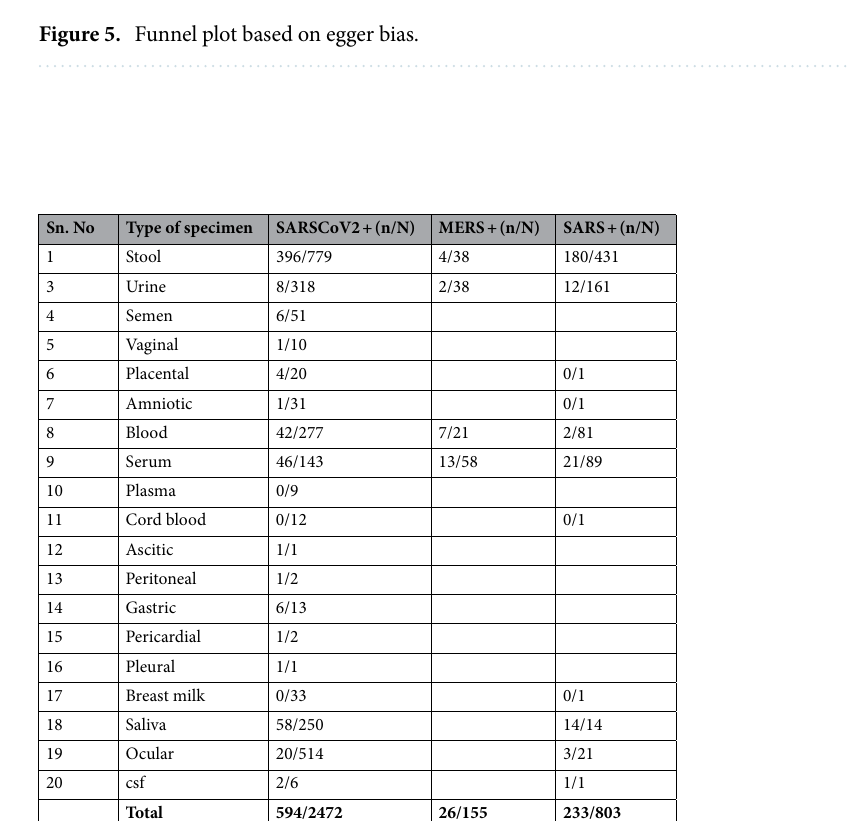
Table 3. Detection of SARS, MERS, SARS CoV-2 in different non-respiratory samples.